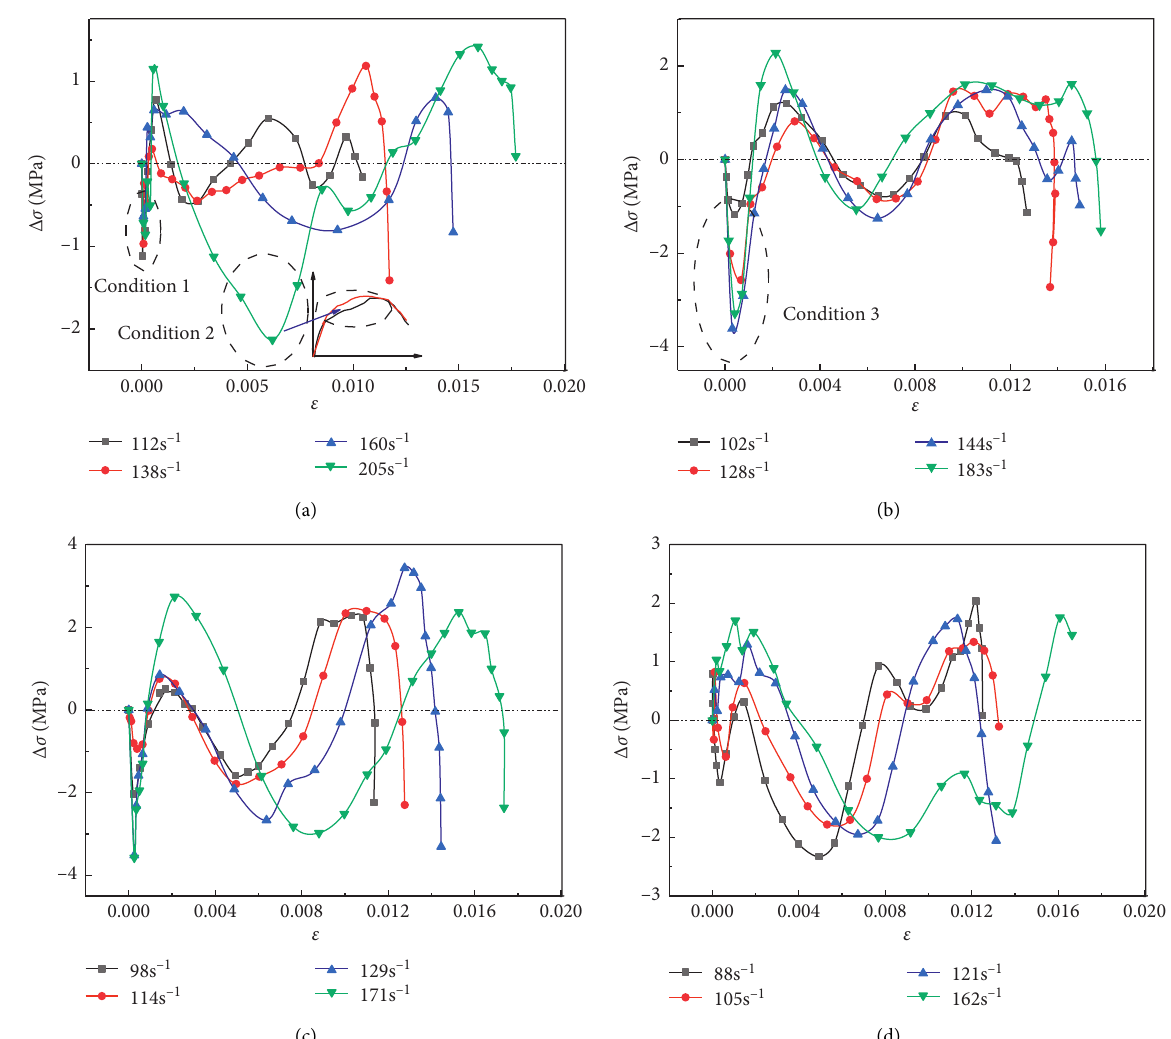
Figure 8: Error analysis of fitting curve. (a) T � 0 ° C. (b) T � − 10 ° C. (c) T � − 20 ° C. (d) T �− 30 °